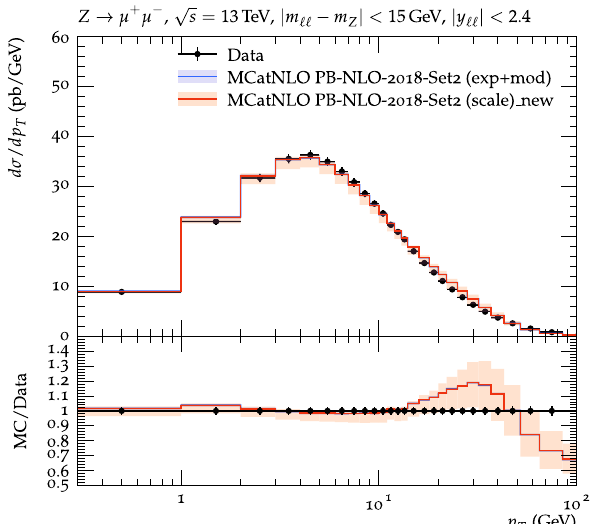
Fig. 7 Transverse momentum spectrum of Z production measured by CMS [7] compared to predictions at NLO using PB-TMDs